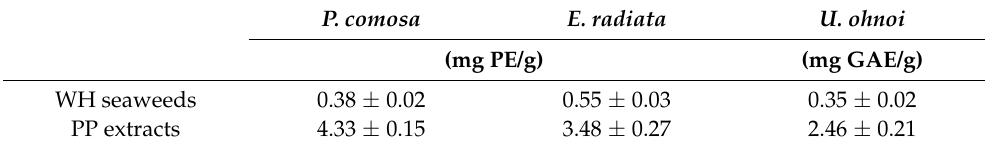
Table 2. Total phlorotannin content of P. comosa and E. radiata and total polyphenol content of U. ohnoi . P.